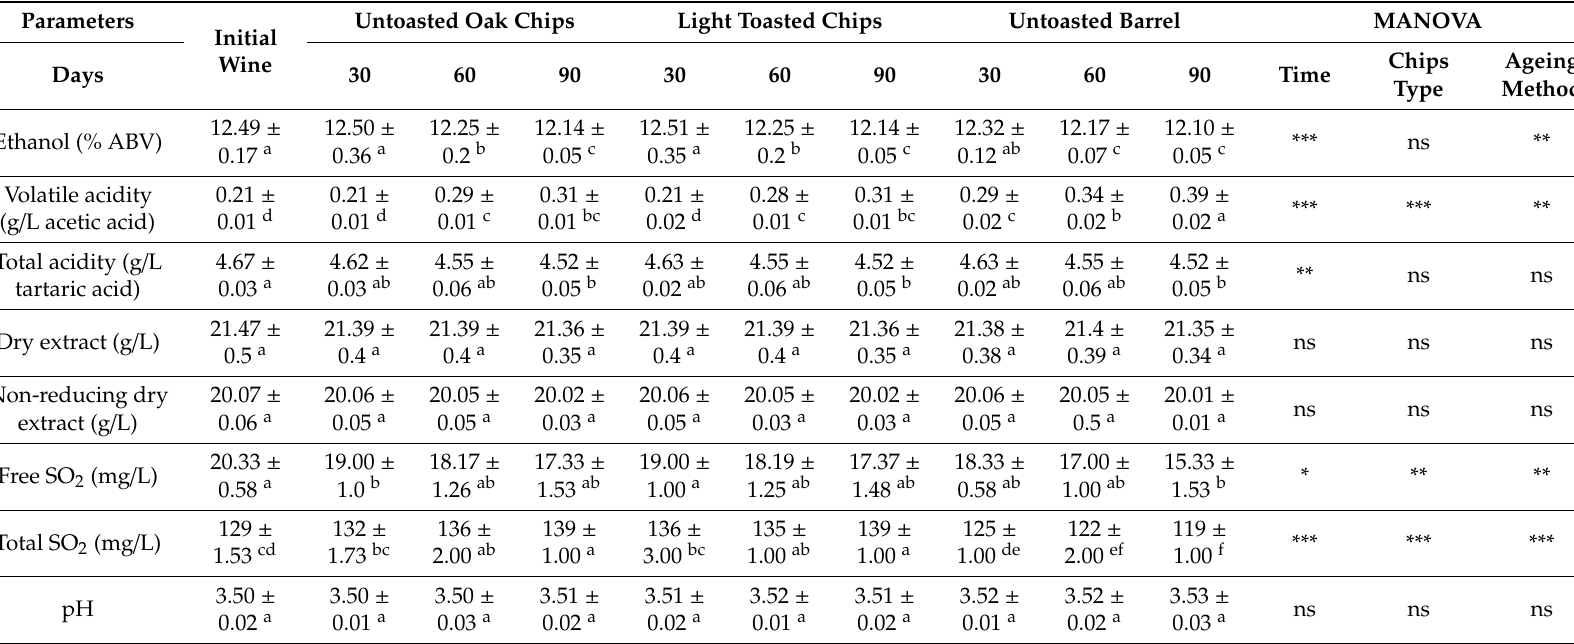
Table 1. Oenological analyses of white wines aged with oak chips and barrel for 30, 60, and 90 days; multivariate analysis of variance (MANOVA) taking as factors time, types of oak chips and ageing